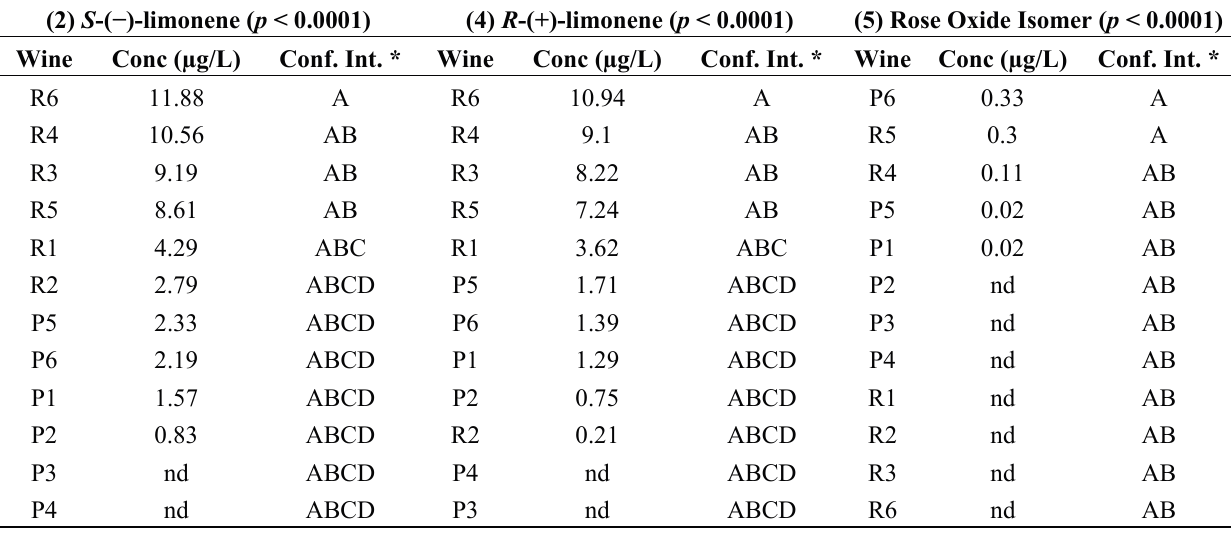
Table 4. Multiple Comparisons (Tukey) of the average concentration of 12 chiral monoterpenes for 12 white